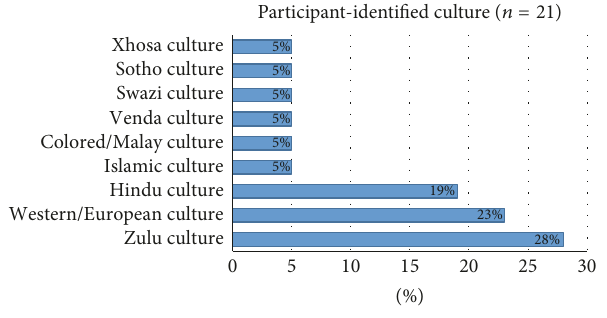
Figure 2: Participants identified culture ( 𝑛 = 21 ).